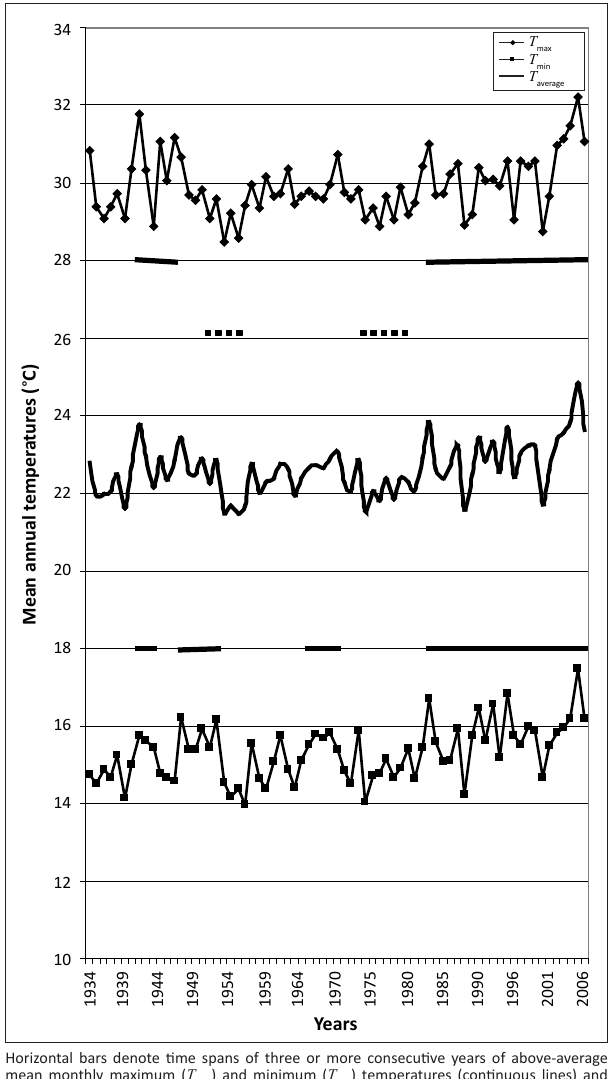
FIGURE 3: Mean annual temperatures at Musina (525 m a.s.l), approximately 100 km north-west of the Kruger National Park (South African Weather